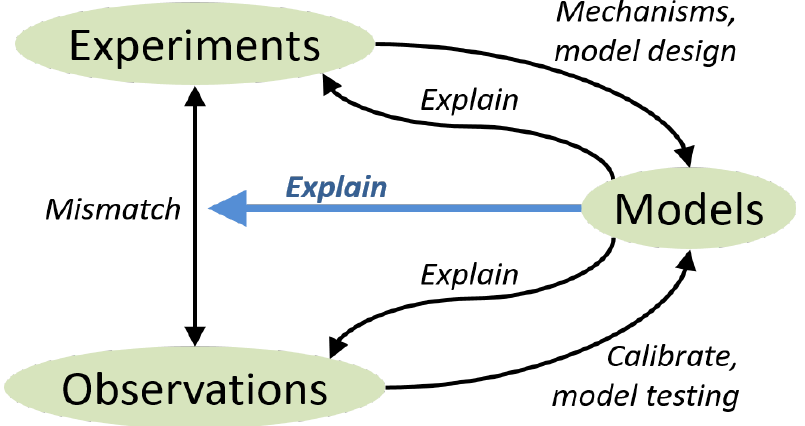
Figure 4. Relationships among experiments, non-intrusive observations and modelling. See main text for discussion.